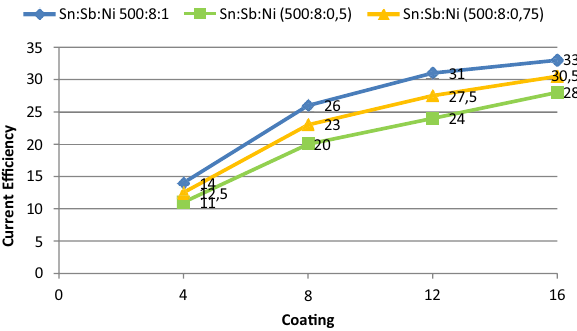
Figure 2. The effect of the number of coatings on the current efficiency in nickel-plated